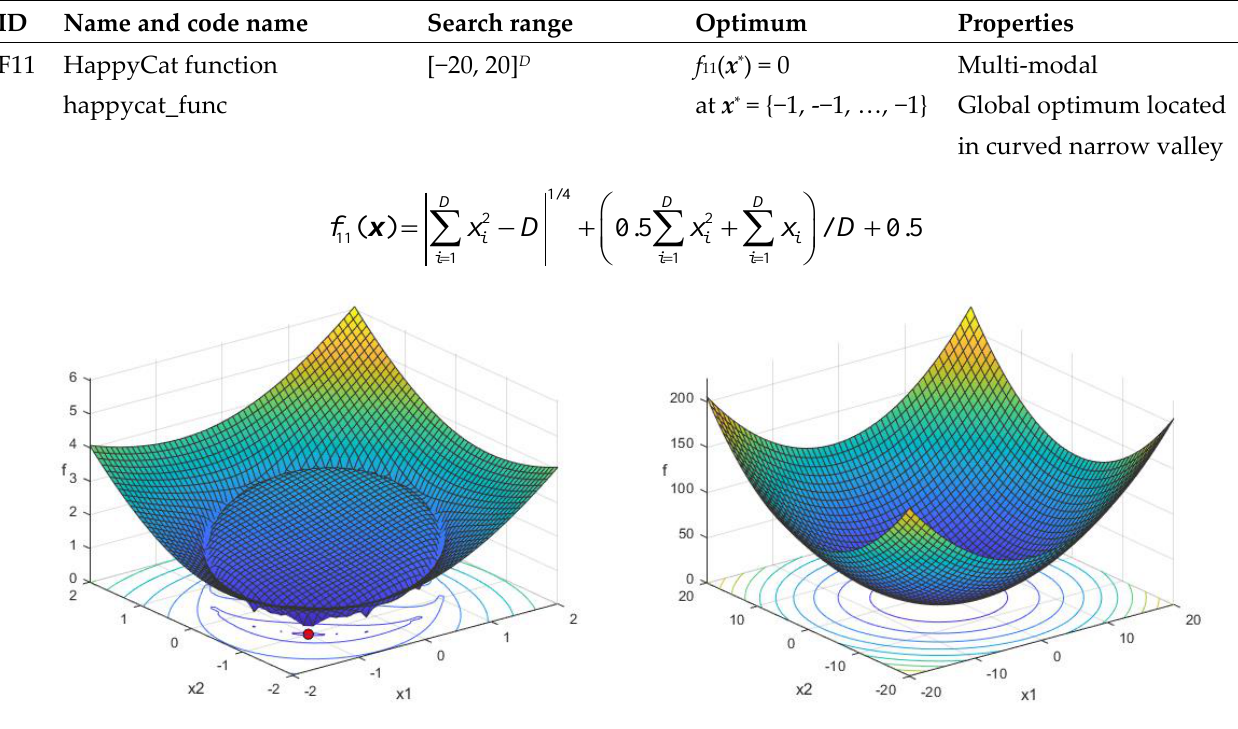
Figure A10. Rastrigin’s function in two dimensions.